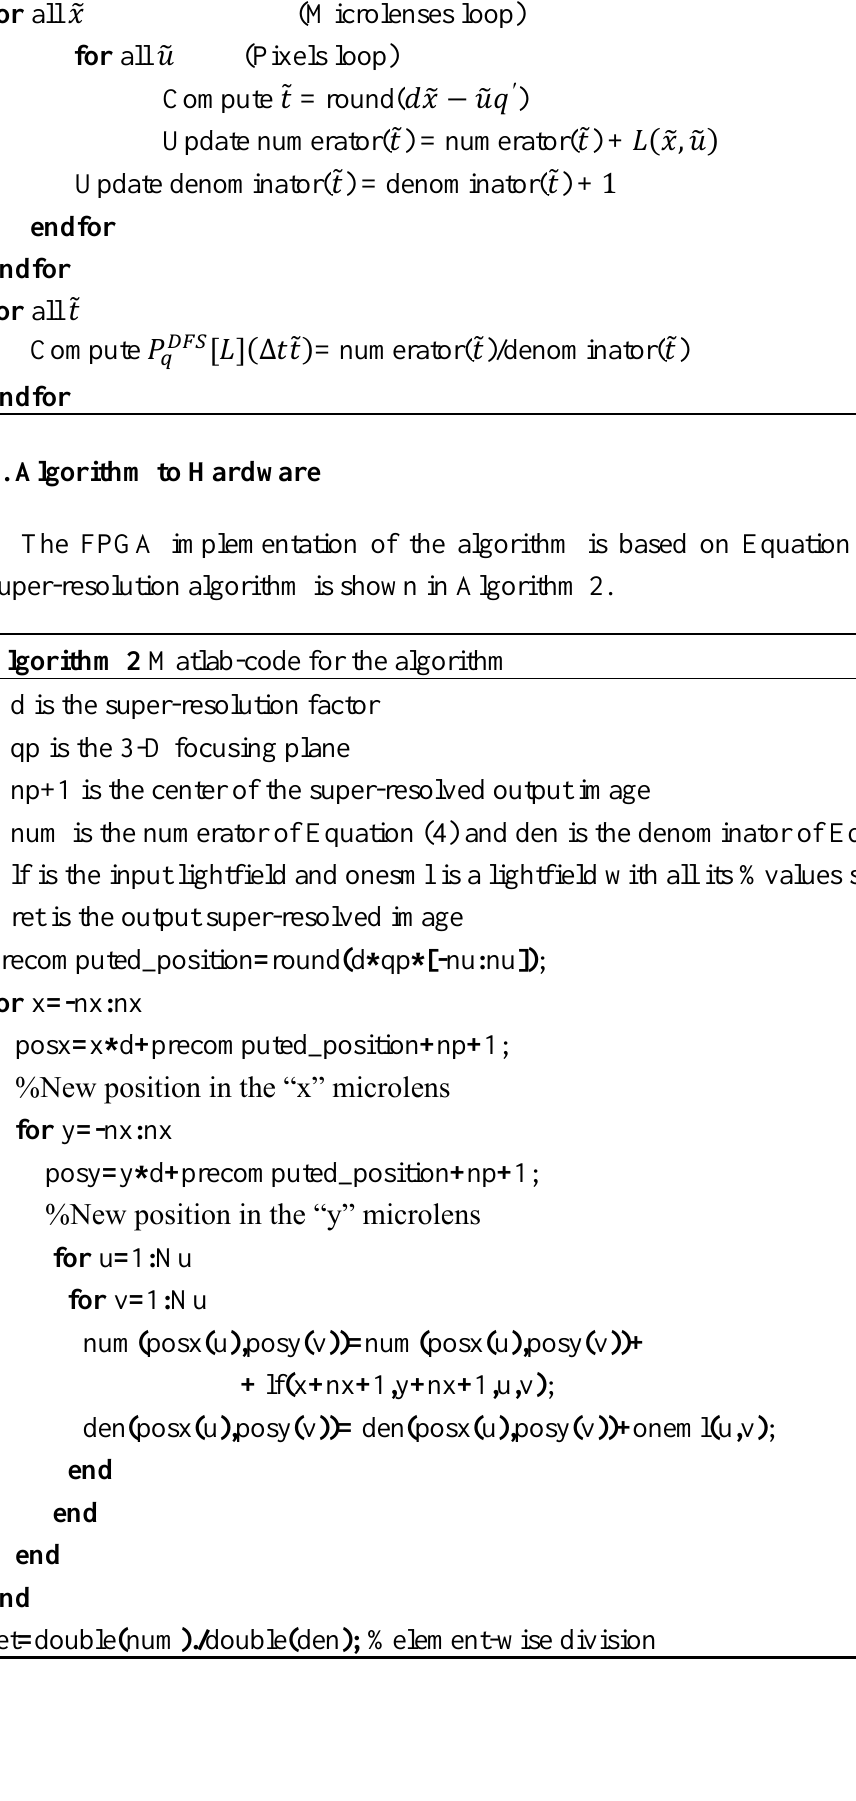
Algorithm 1 Pseudo-code for the algorithm